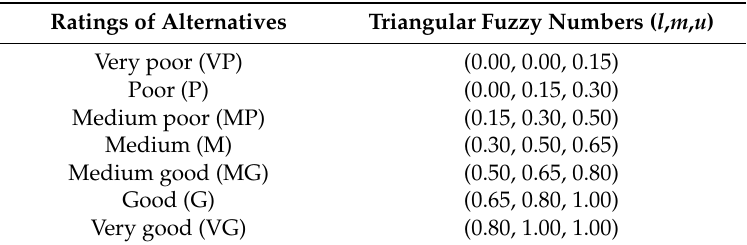
Table 11. Linguistic variables and the corresponding fuzzy